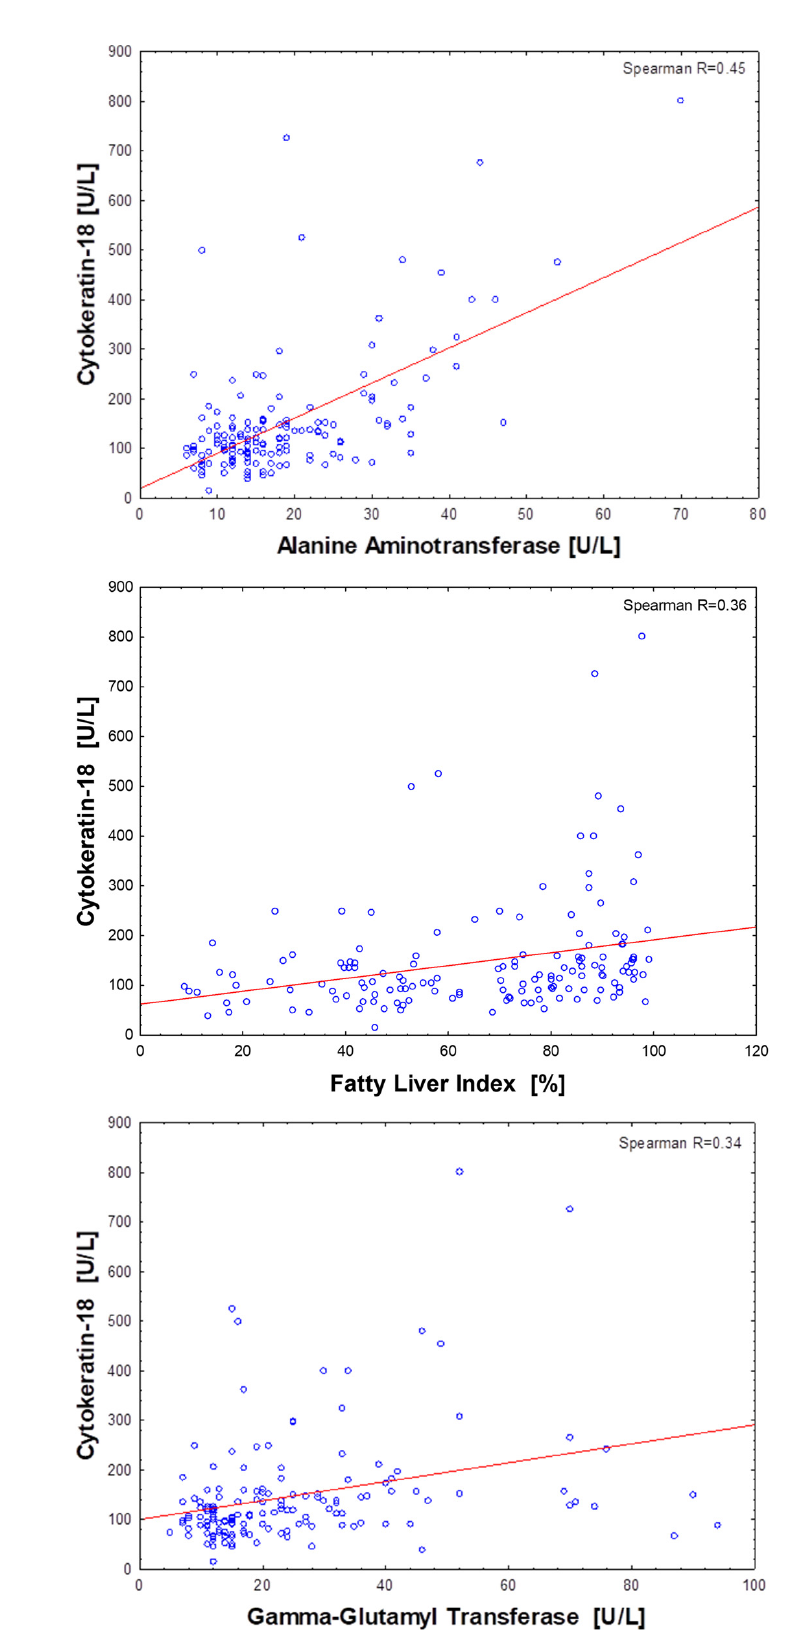
Figure 2. Scatter plot of the cytokeratin-18 plasma level and alanine aminotransferase ( a ), fatty liver index ( b ) and gamma-glutamyl transferase ( c ) activity in all subjects ( n = 151). Table 3. Spearman rank correlation between cytokeratin-18 plasma levels and anthropometrics, liver markers and metabolic variables in the entire group of subjects participating in the study ( n = 151).